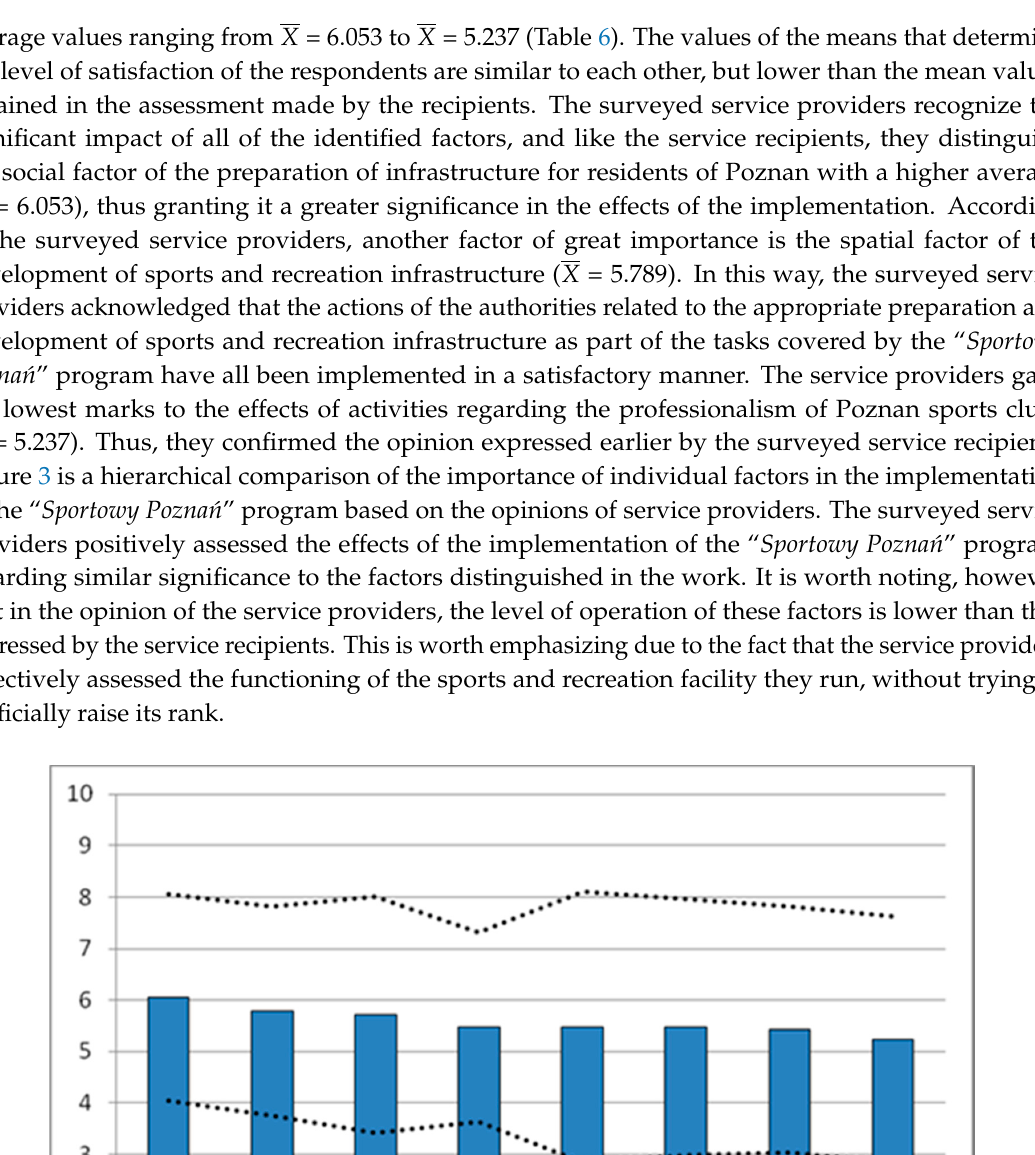
Table 6. Statistical characteristics of the importance of individual factors based on the opinions of service providers.